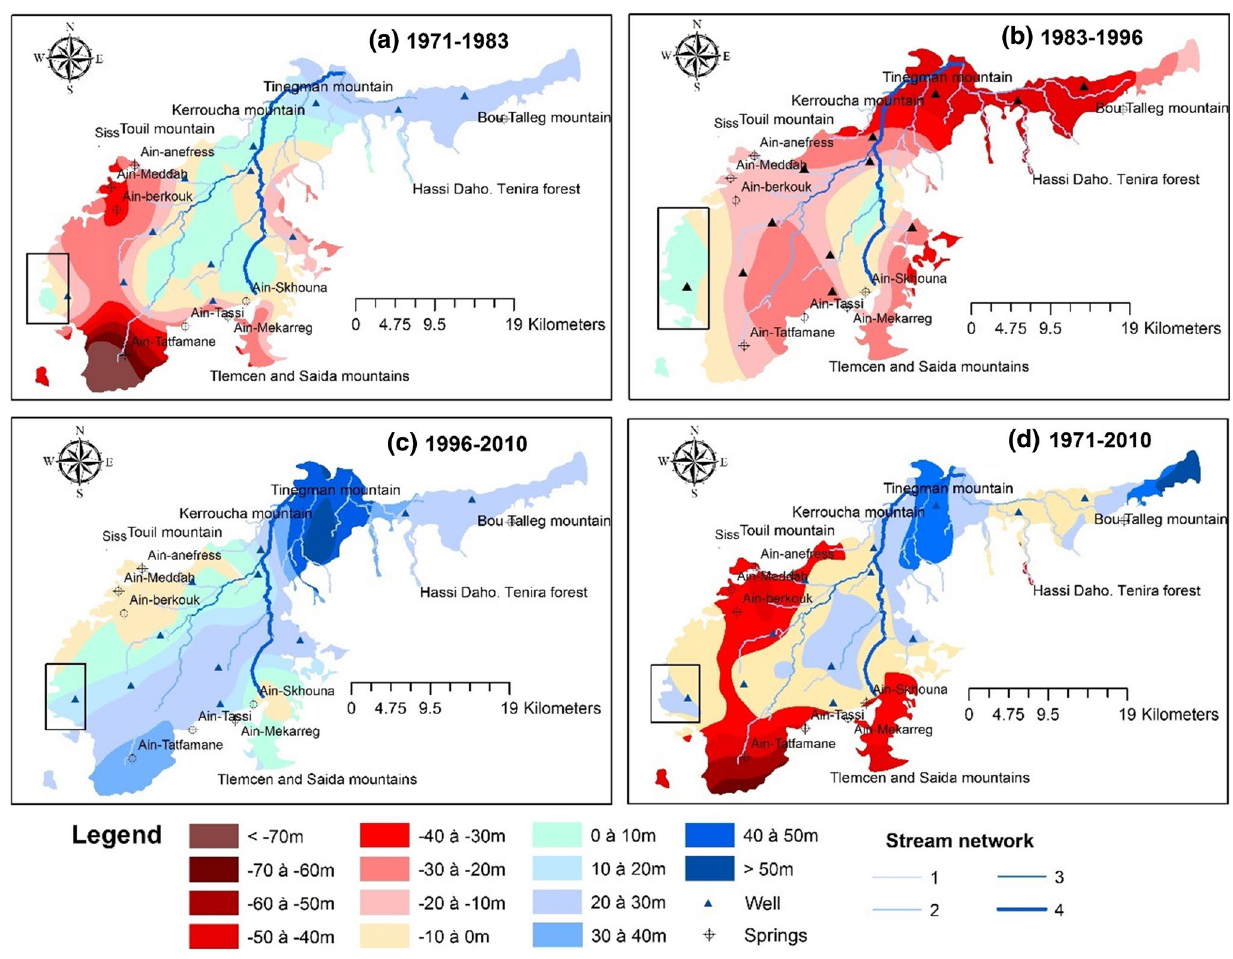
Fig. 11 Spatio-temporal evolution of groundwater